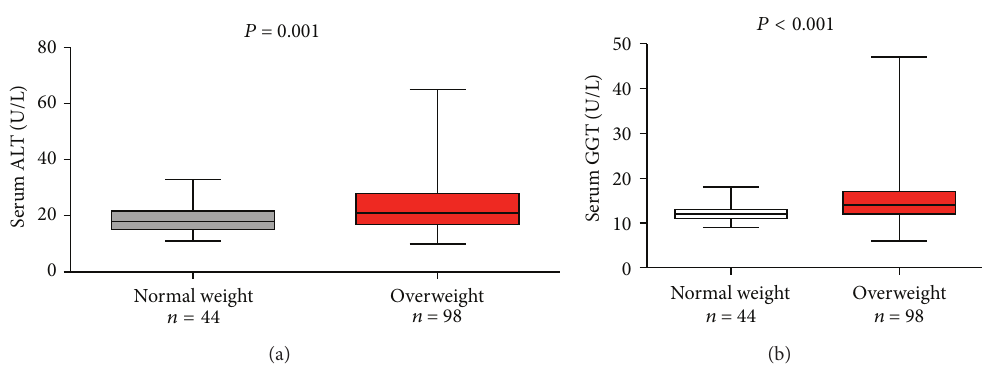
Figure 1: Obese children present with increased serum ALT and GGT activities. Serum ALT (a) and GGT (b) activities differed significantly ( 𝑃 = 0.001 and 𝑃 < 0.001 , resp.) between obese and normal weight children. We did not detect any significant differences between both groups with respect to the AST activities ( 𝑃 > 0.05 ).